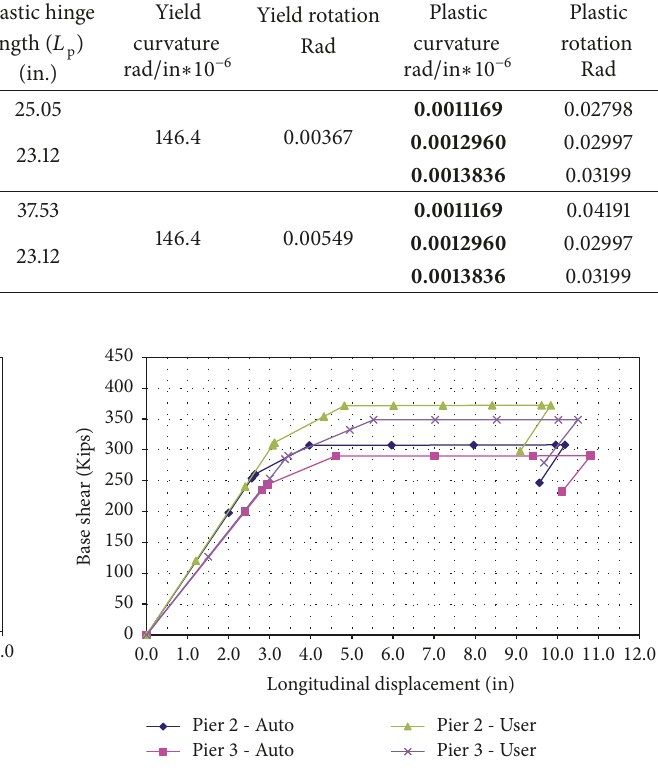
Figure 8: Longitudinal pushover capacity curve of Bridge #3-E. Figure 9: Longitudinal pushover capacity curve of Bridge